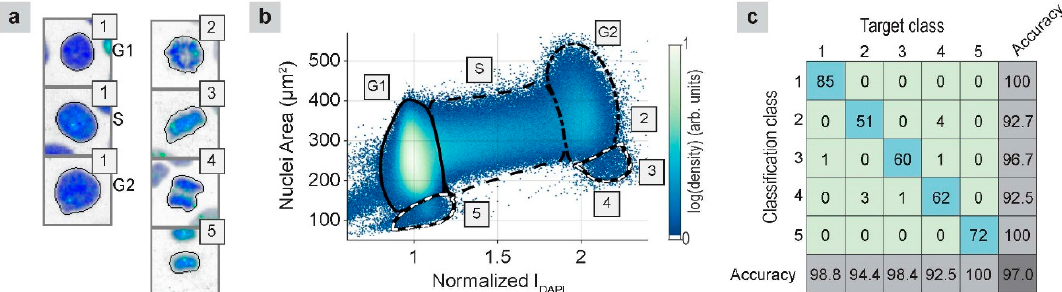
Figure 2. ( a ) Examples of nuclei from each classification group; 1: interphase, 2: prometaphase,